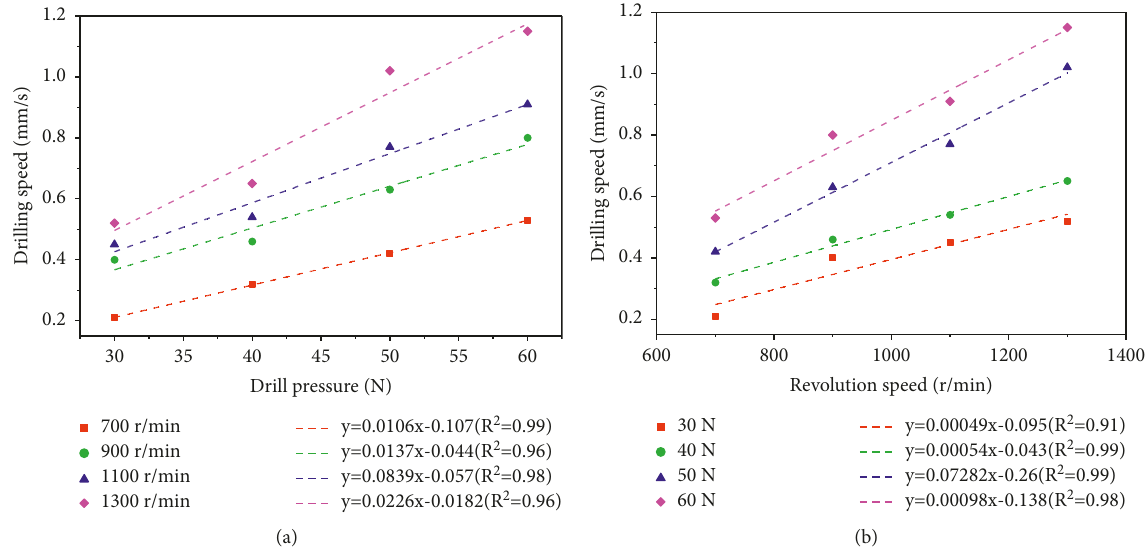
Figure 15: The variations of the DS with (a) the DP and (b) the RS of red sandstone. 0.00.51.01.52.0